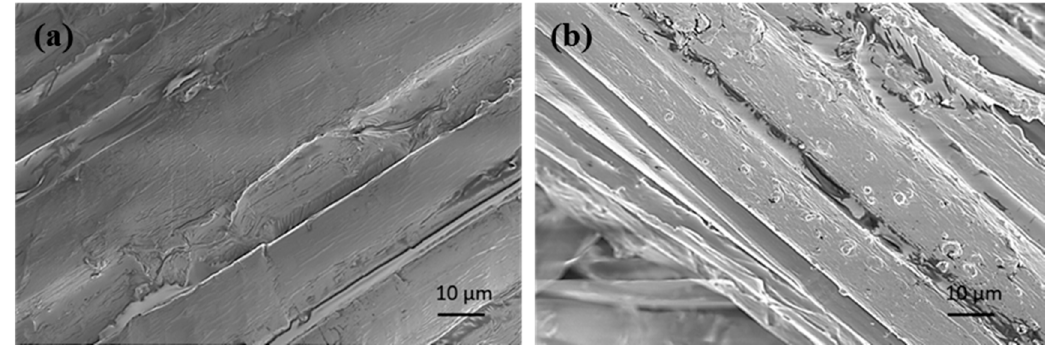
Figure 2. The surface morphology of flax fiber ( a ) untreated and ( b ) silane treated.